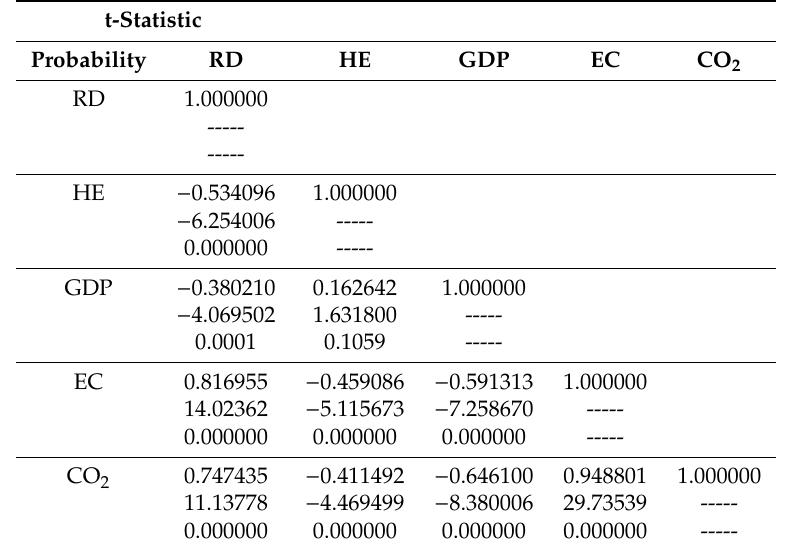
Table 2. Correlation